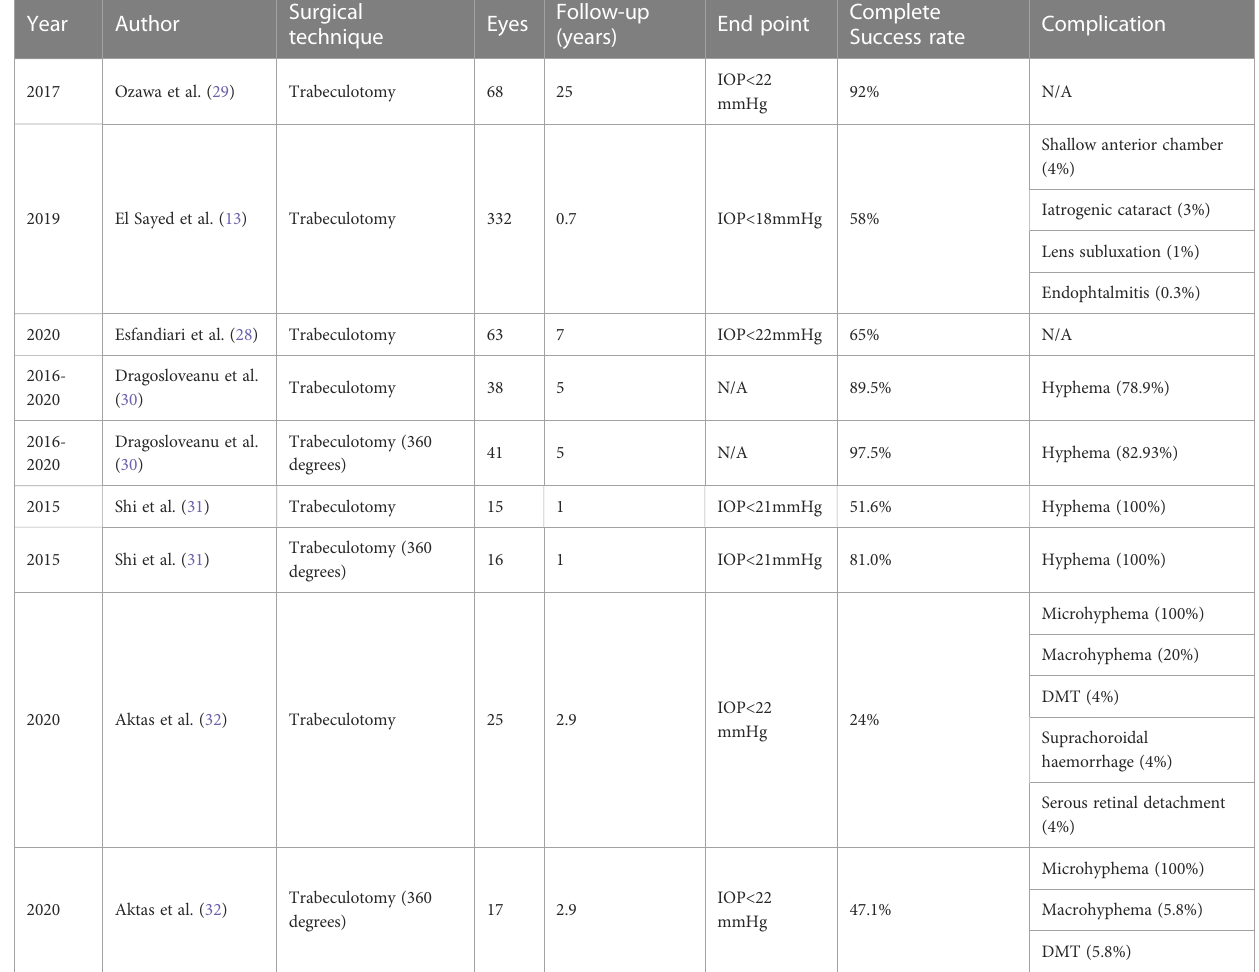
TABLE 2 Summary various studies on surgical treatment for Primary Congenital Glaucoma